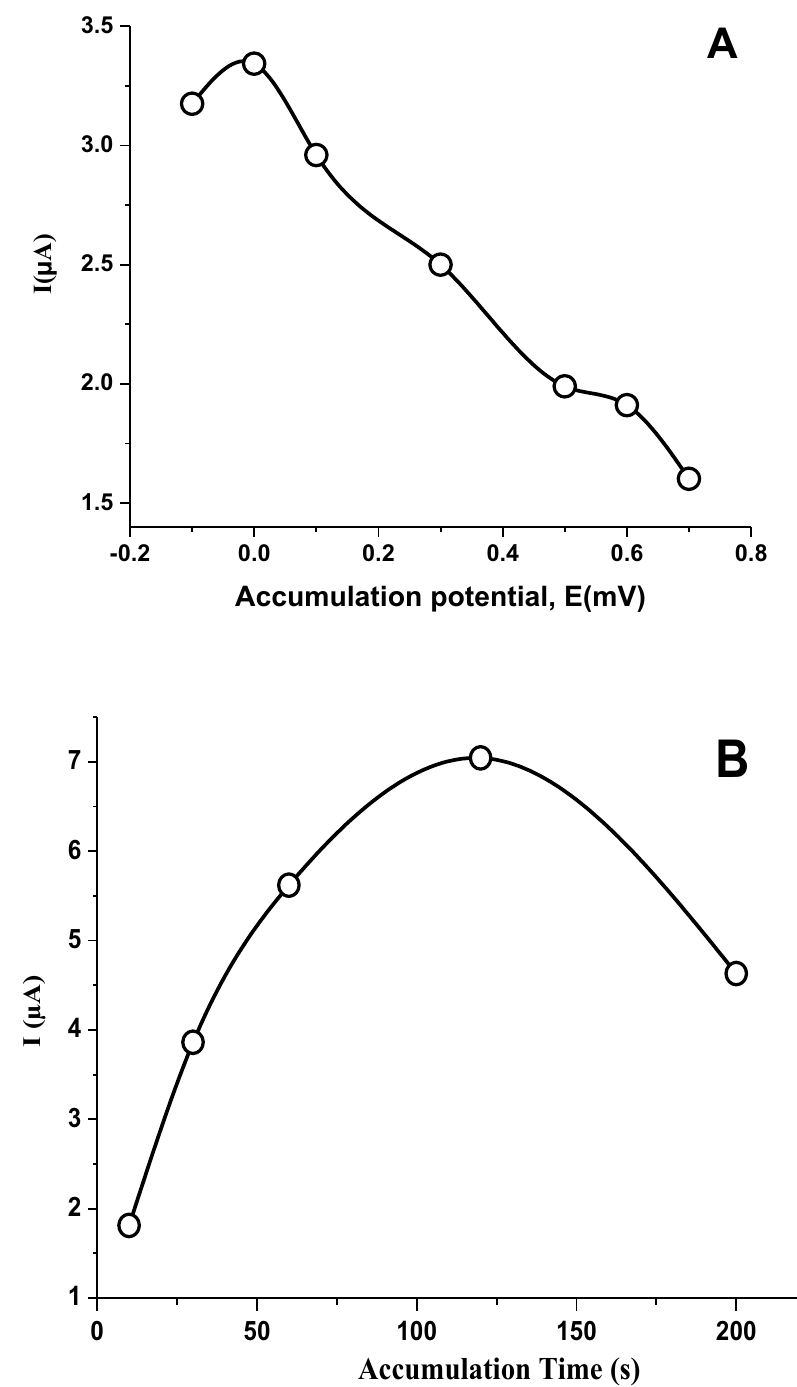
Figure 7. ( A ) Accumulation potential effect on the peak currents with 30 s of accumulation time. ( B ) Accumulation time effect on the peak currents, with an accumulation potential at 0.0 mV for 5 × 10 –6 M IDA in pH 1.5 phosphate buffer utilizing the AdSDPV